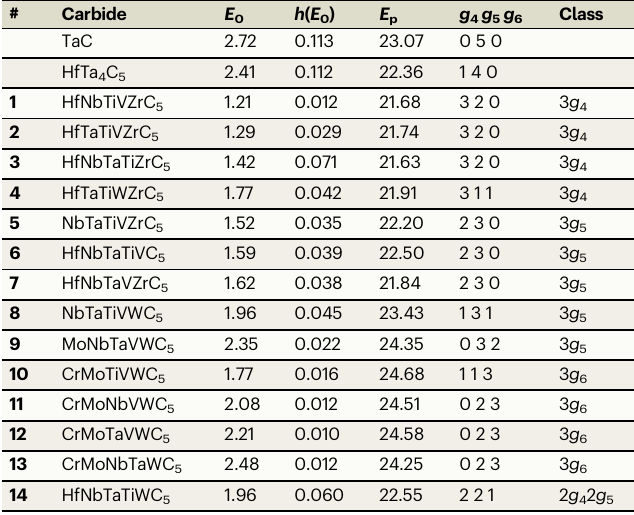
Table 1 | List of simulated TM-carbides and PHEC structures at varying composition